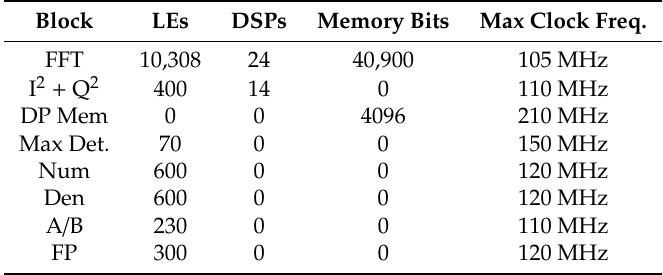
Table 4. Resource utilization and frequency of each processing module in a Cyclone III